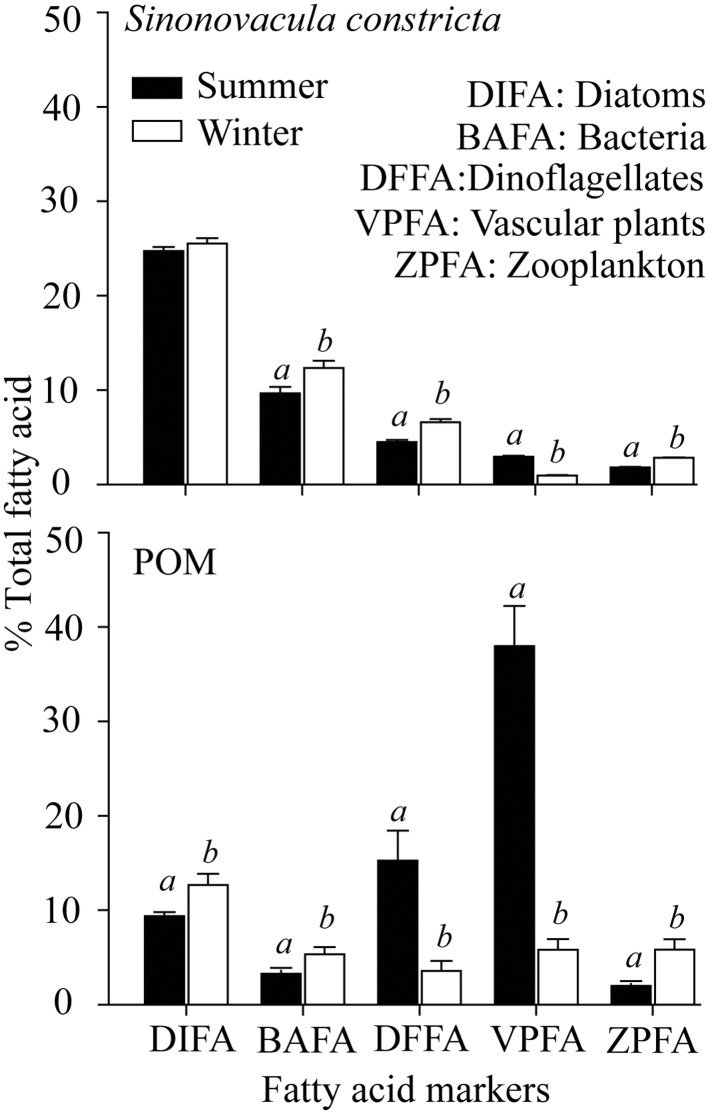
Relative percentages of fatty acid markers (diatoms, bacteria, dinoflagellates, vascular plants and zooplankton) from bivalve (Sinonovacula constricta) and POM in summer and winter.Different superscript letters (a, b) refer to significant differences between summer and winter.